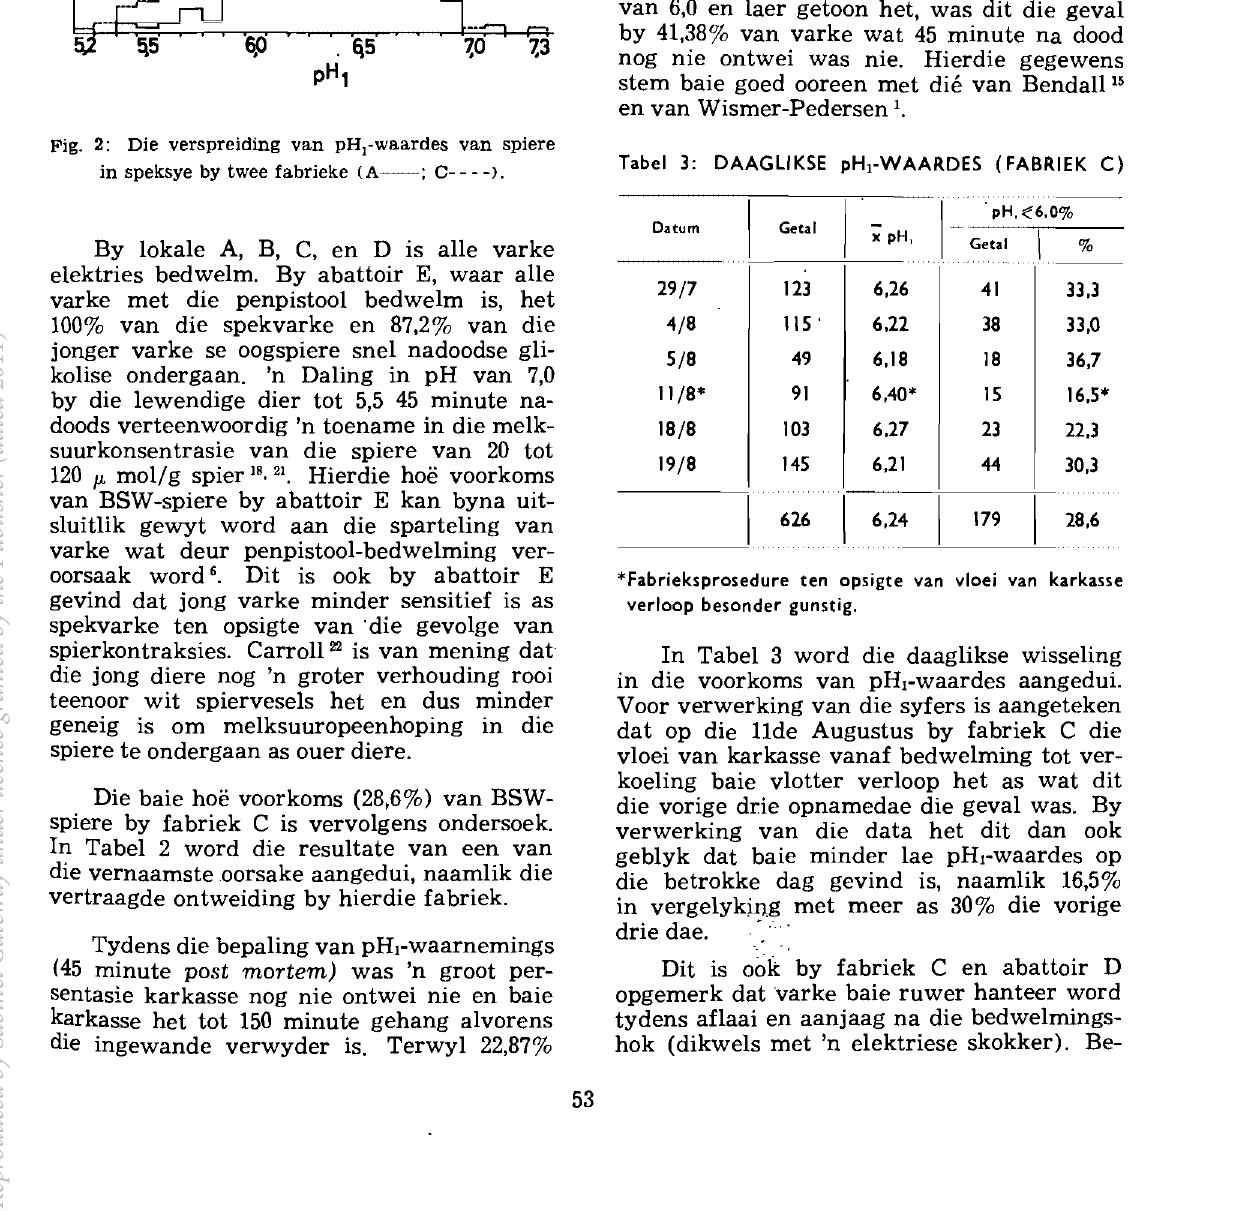
Fig. 2: Die verspreiding van pHI-waardes van spiere in speksye by twee fabrieke (A--; C----).